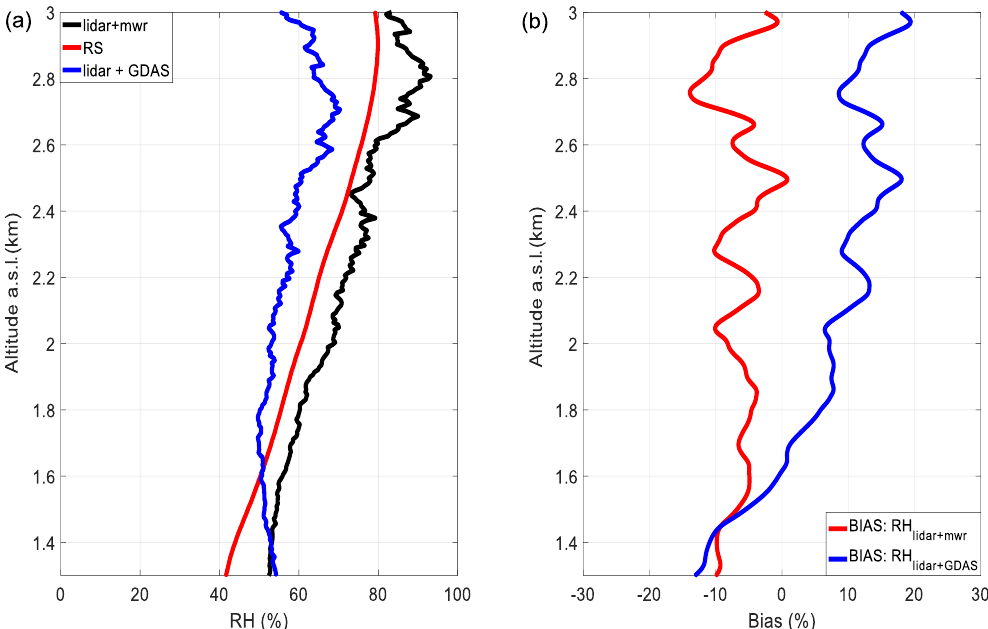
Figure 2. RH comparison for 22 July 2013 around 20:00–21:00UTC. (a) RH profiles retrieved from a combination of lidar + MWR (black line), lidar + GDAS (blue line), and RS (red line); and (b) bias calculation between lidar + MWR (red line) and lidar + GDAS (blue line).